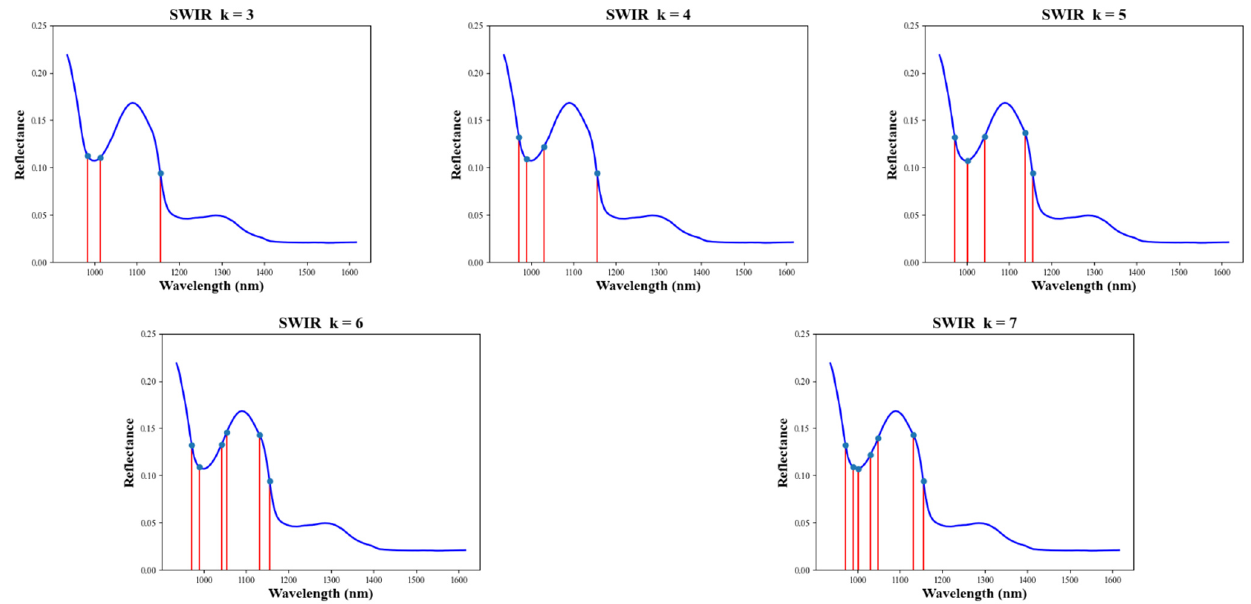
Figure 8. Average fluorescence spectrum for one of the red snapper fillets with the optimal k = 3, 4, 5, 6, 7 wavelength selections.